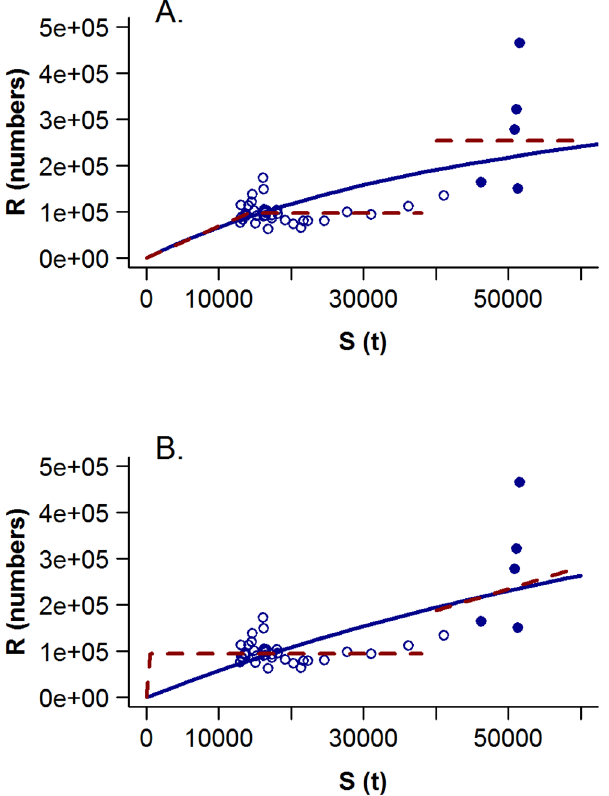
Fig 1. Candidate spawner-recruitment relationships fit to stock assessment outputs for western Atlantic bluefin tuna assuming τ = 1. The solid circles represent the year-classes from 1970 to 1975 and the hollow circles represent subsequent year-classes. The solid lines represent the Beverton-Holt curve fit to the entire time series and the dashed lines represent A) the three-line regime-shift model and B) the Beverton-Holt regime shift